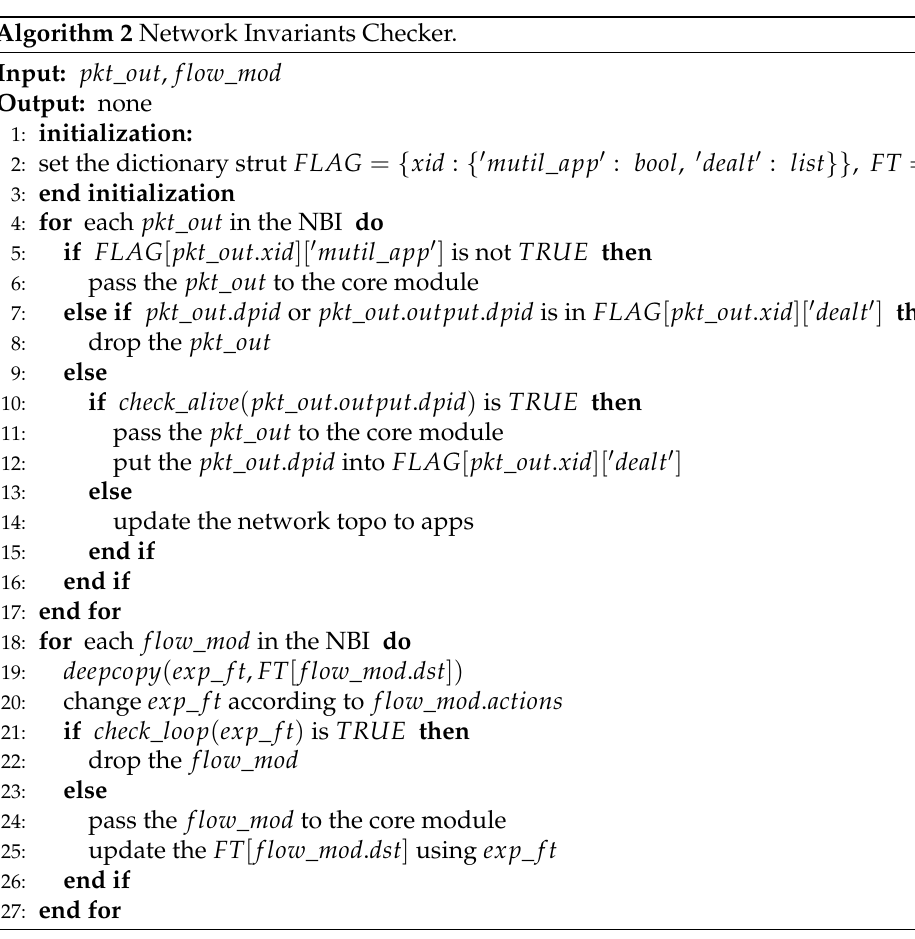
Algorithm 2 Network Invariants